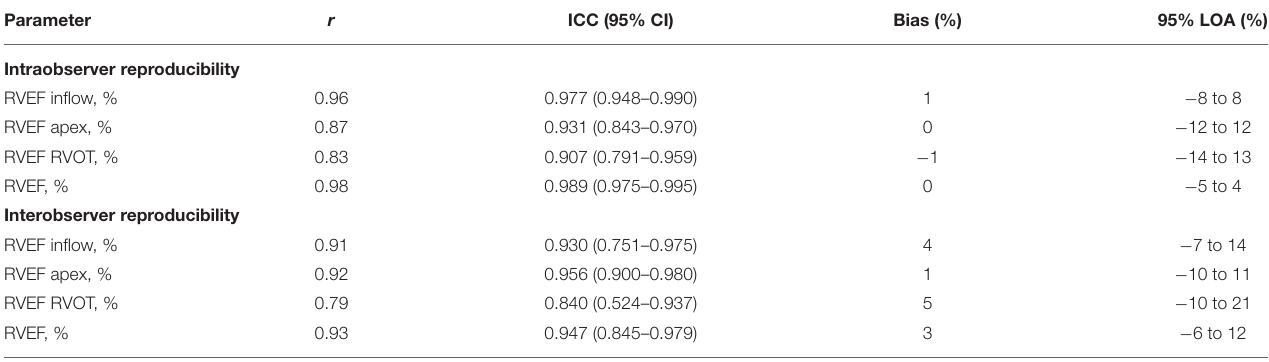
TABLE 4 | Intra- and interobserver reproducibility analysis for global and regional RVEF.